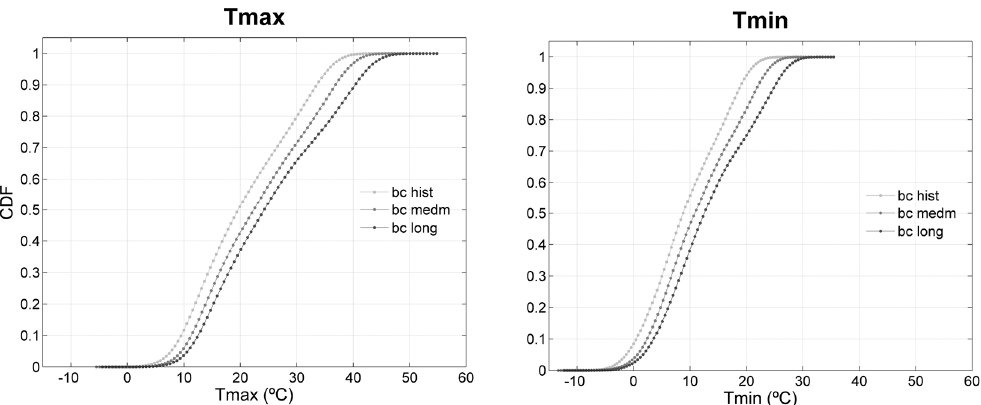
Figure 8. Cumulative distribution function (CDF) of the historical period (bc hist), medium- (bc medm), and long-term future (bc long), for the daily maximum and minimum temperature (Tmax and Tmin, °C) (left and right, respectively) for Madrid.